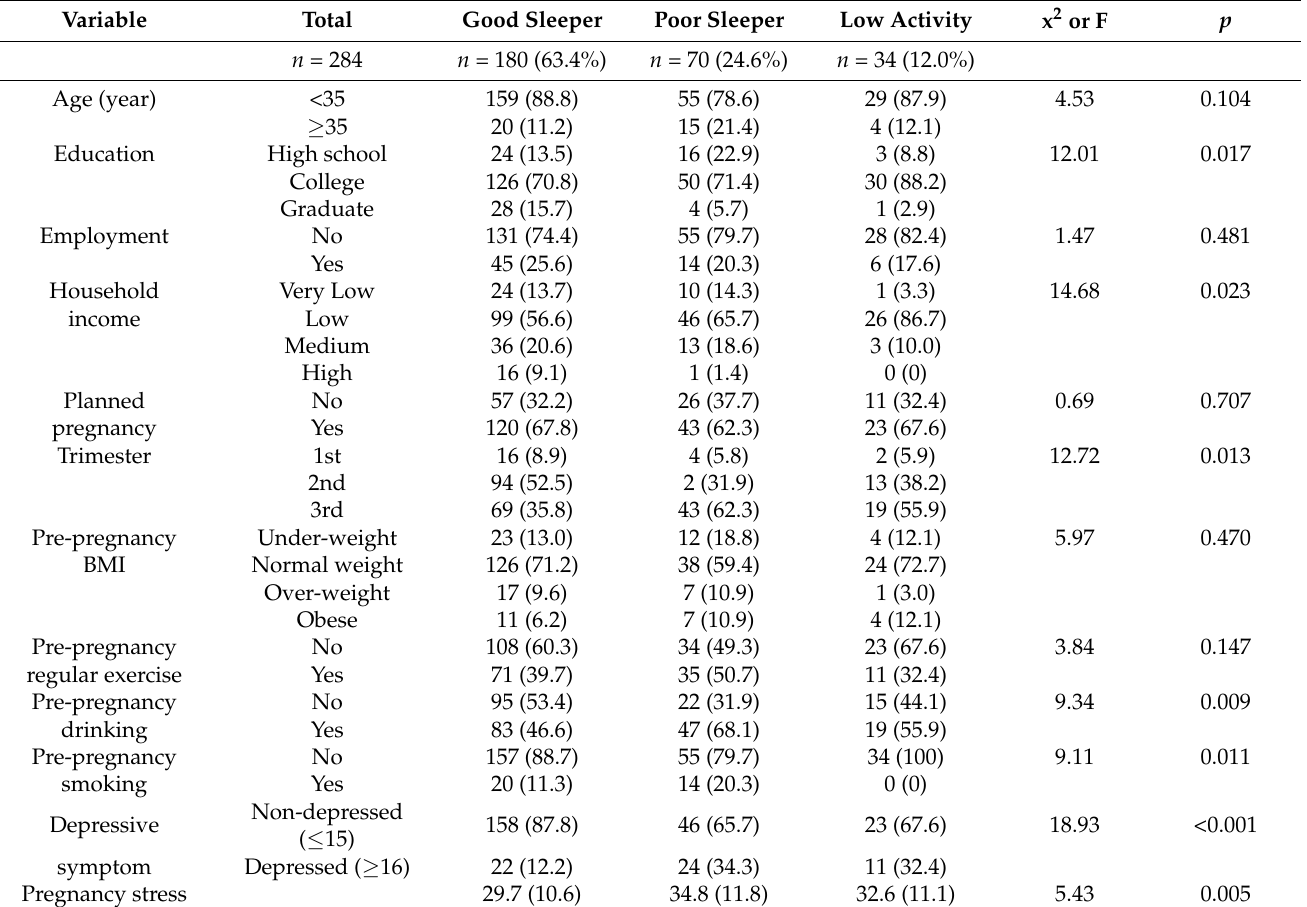
Table 3. Comparison of pre-pregnancy characteristics between clusters ( n (%)/Mean